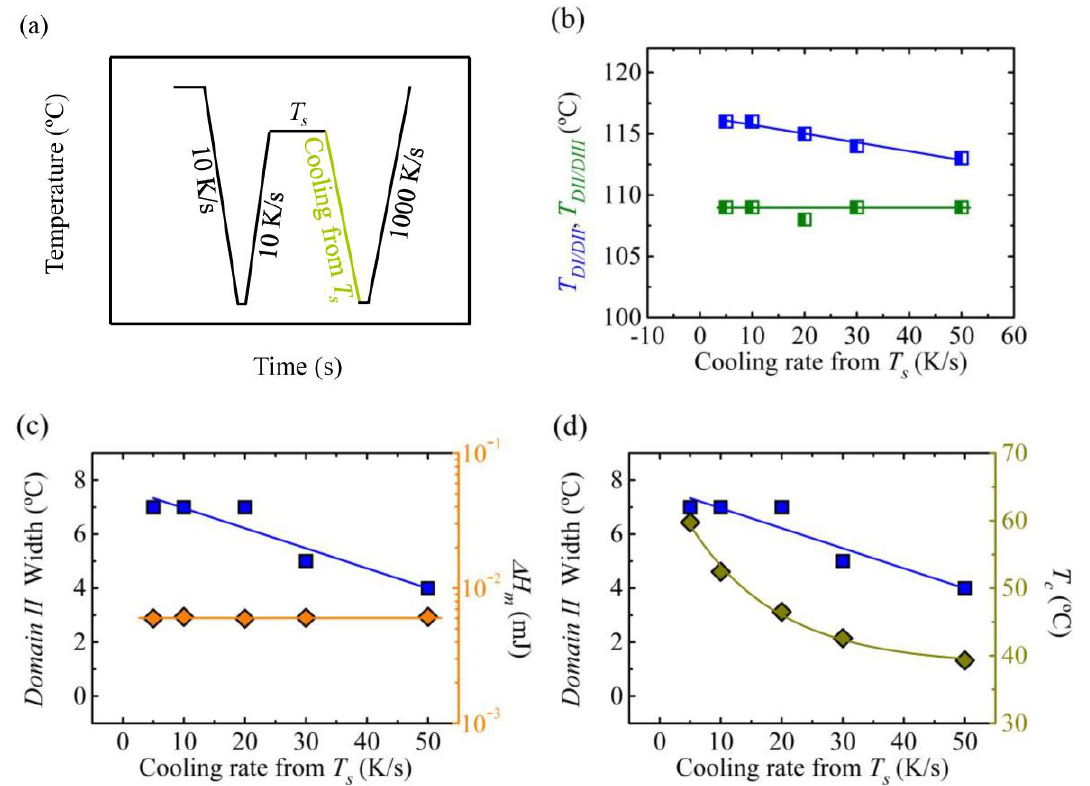
Figure 5. ( a ) Thermal procedure employed varying the cooling rate from T s temperature, in order to erase the thermal history the sample is kept at 160 ◦ C for 30 s and it is cooled down to − 50 ◦ C, the sample is kept at this temperature, − 50 ◦ C, for 0.1 s, the sample is kept at T s temperature for 300 s, ( b ) transition temperature between Domains as a function of cooling rate from T s , ( c ) width of Domain II and melting enthalpy (when heating to T s ) and ( d ) crystallization temperature cooling from T s as a function of cooling rate from T s .